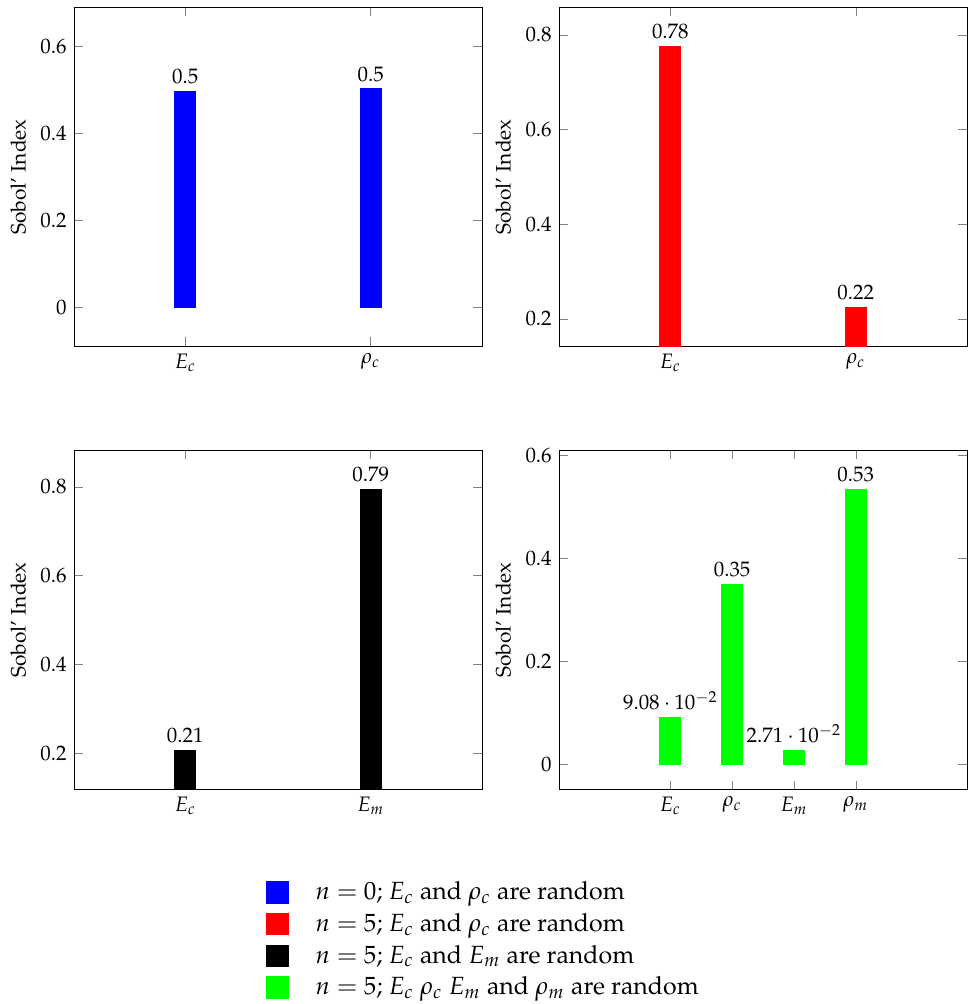
Figure 9. Sensitivity study of the random parameters using the first order Sobol’ index for the first fundamental frequency of the functionally graded material plate.